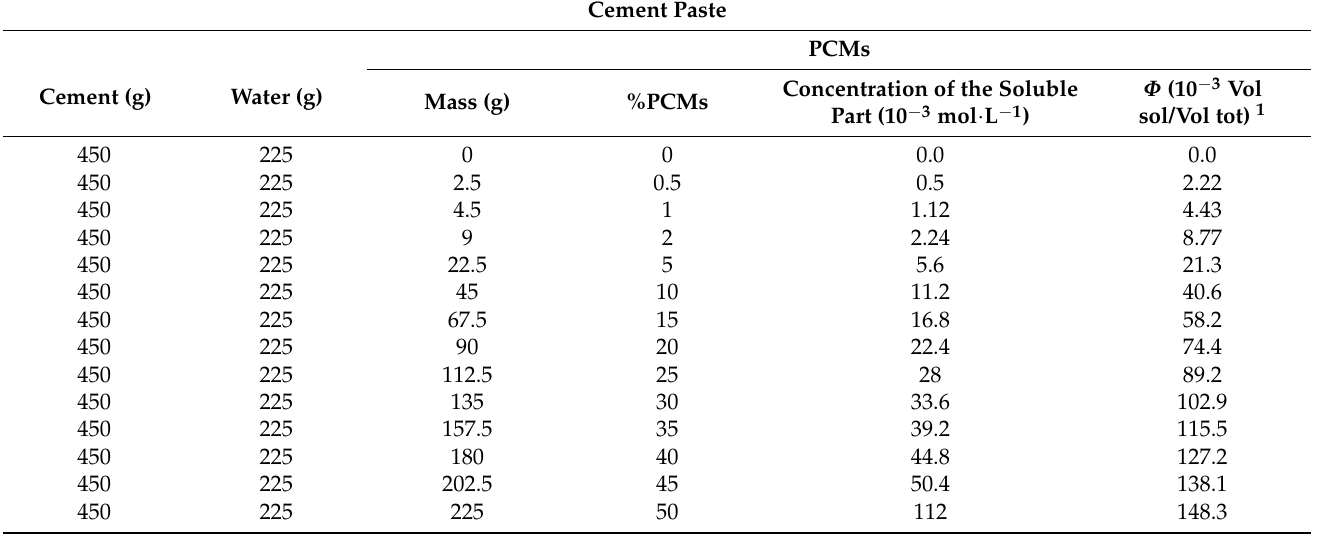
Table 1. Mix design of cement pastes.